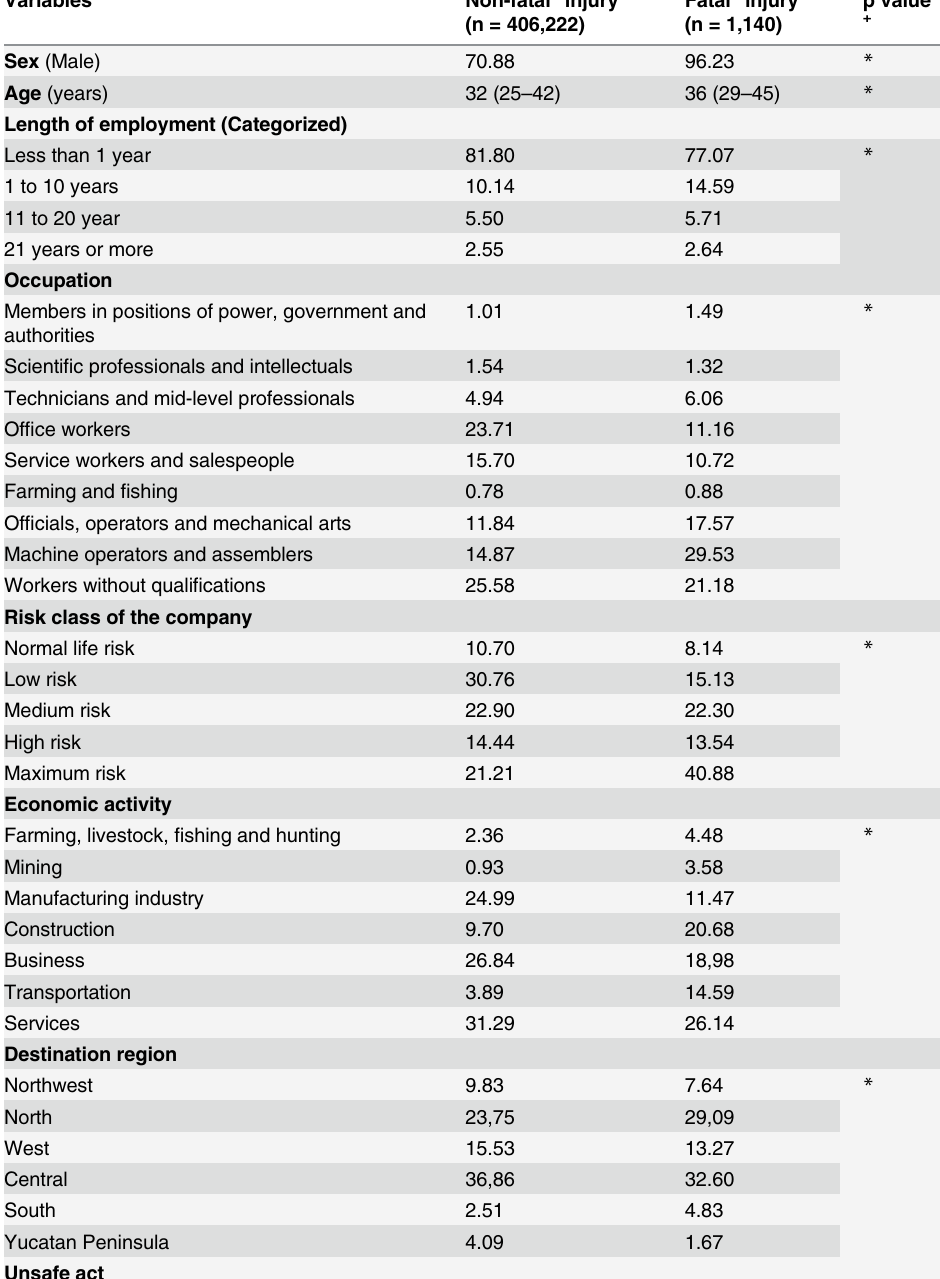
Table 2. Characteristics related to sociodemographics and the company, according to the type of consequence — non-fatal occupational injury (with temporary disability and without sequels, or without disability) and fatal occupational injury (death) — among workers af fi liated with the IMSS in Mexico in